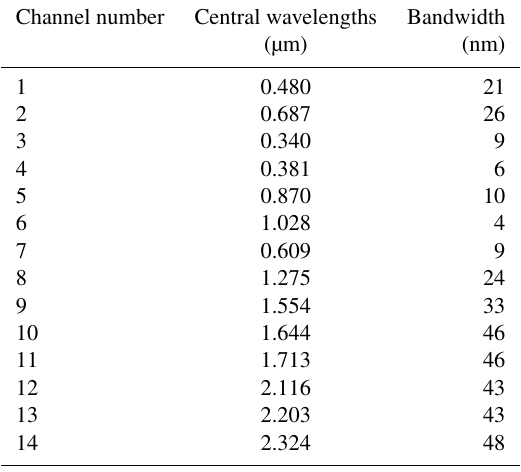
Table 2. Summary of CAR wavelengths and